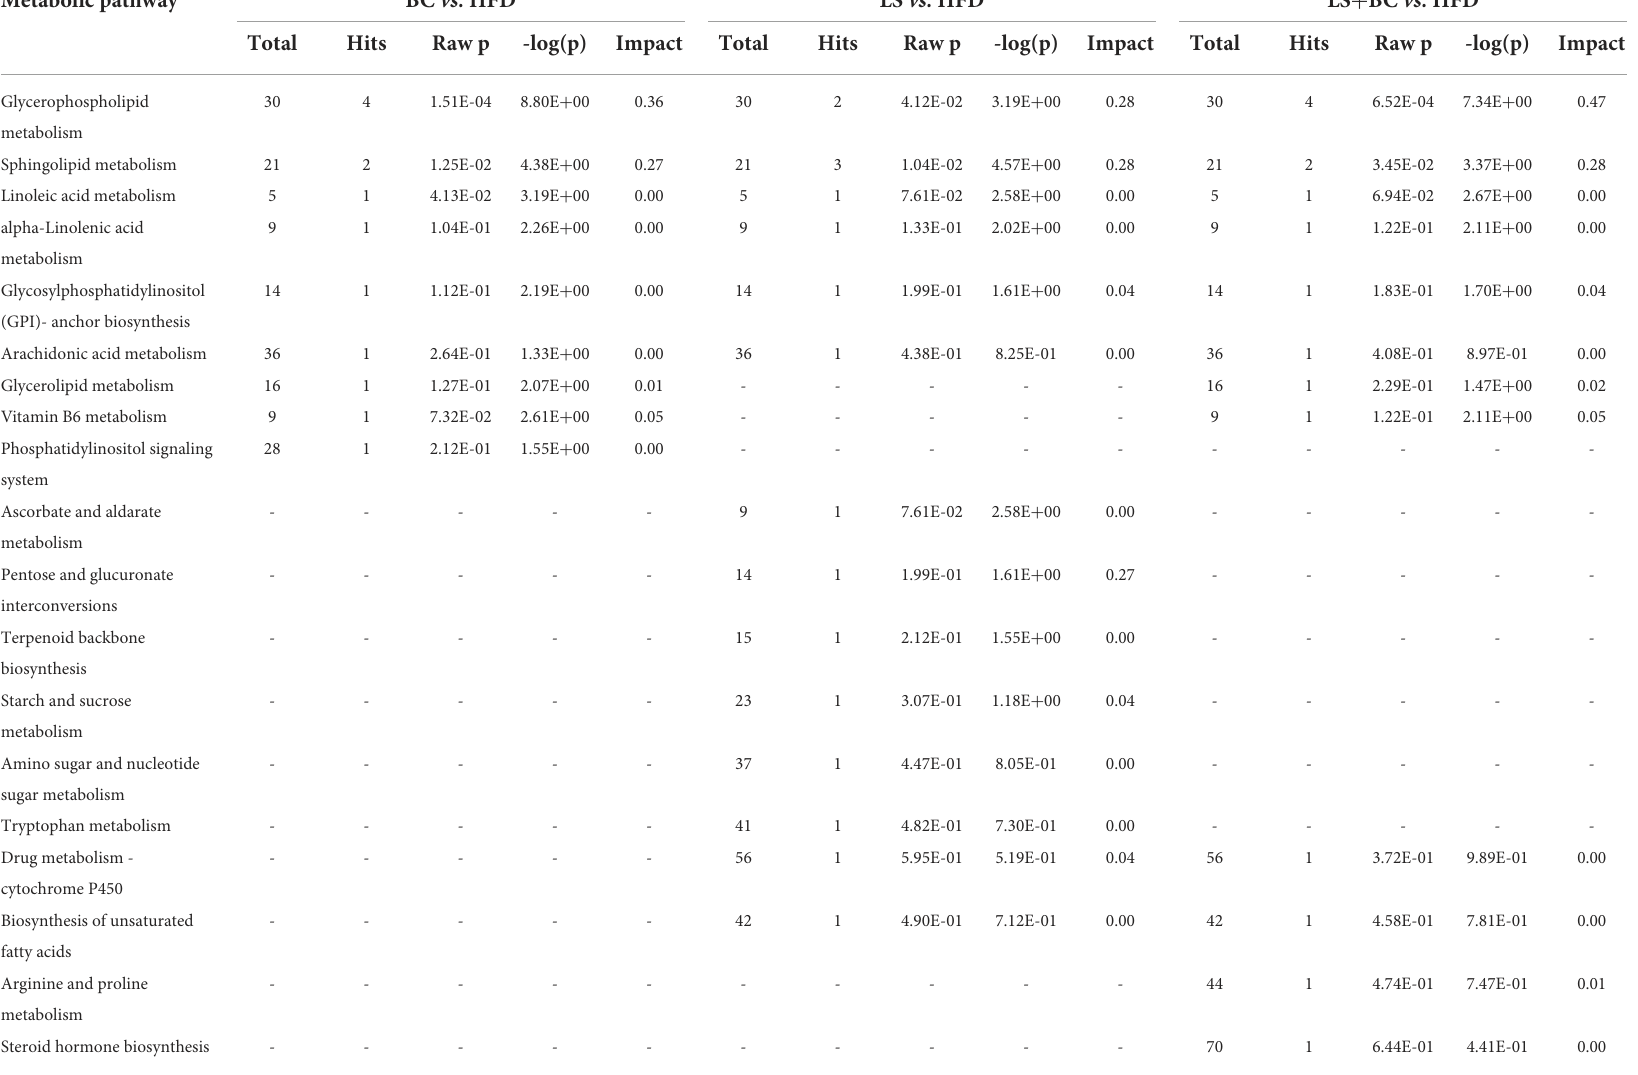
TABLE 2 The result of pathway enrichment analysis of plasma in BC group vs. HFD group, LS group vs. HFD group and LS + BC group vs. HFD group * . Metabolic pathway BC vs. HFD LS vs. HFD LS + BC vs.